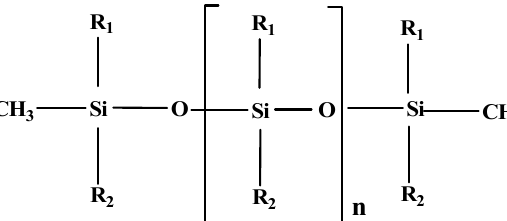
Figure 1. Schematic representation of a silicone molecule. R 1 and R 2 represent different substituent groups, such as methyl, phenyl, vinyl, hydroxyl, or halogen. Adapted from [24].